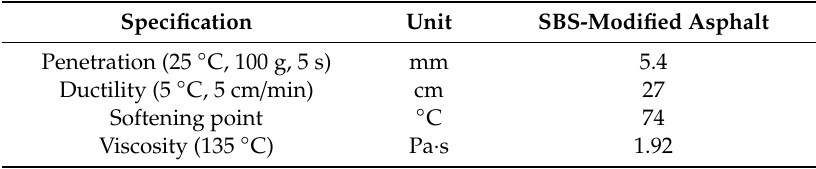
Table 3. Properties of SBS-modified bitumen.